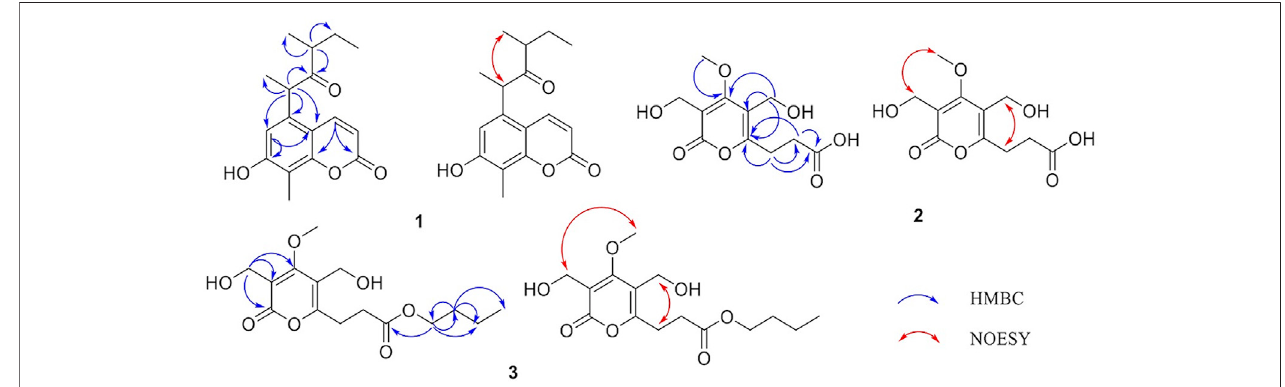
FIGURE 2 | Key HMBC (blue) and NOESY (red) correlations of 1 –